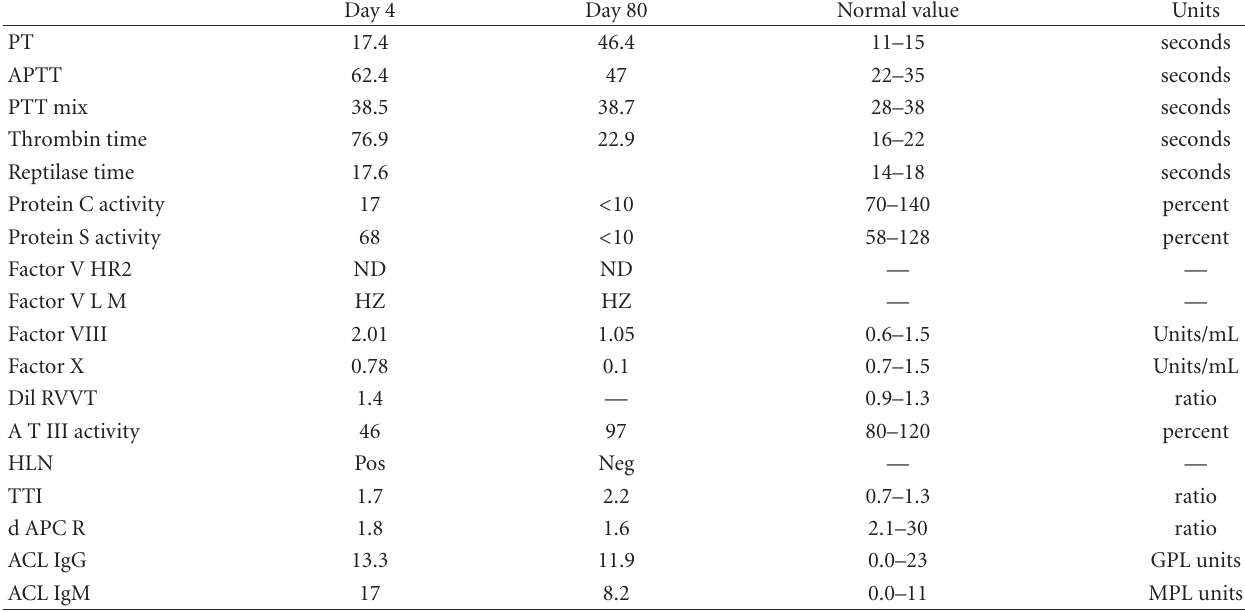
Table 1: Thrombophilia